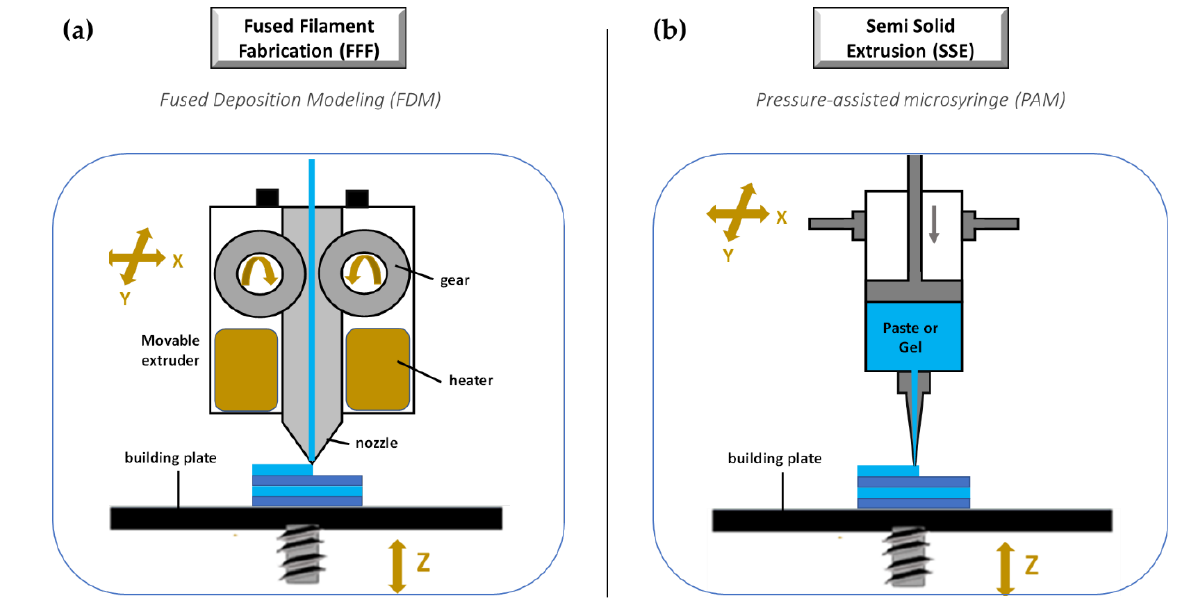
Figure 11. Illustration of FFF ( a ) and SSE ( b ) processes. Semi Solid Extrusion (SSE)